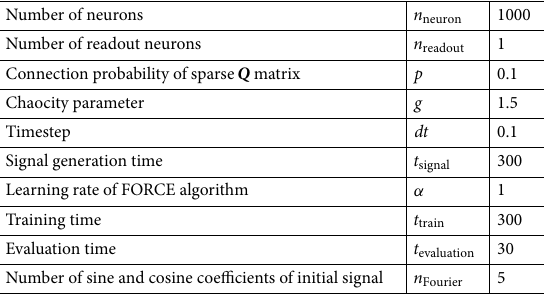
Table 2. Fixed parameters.